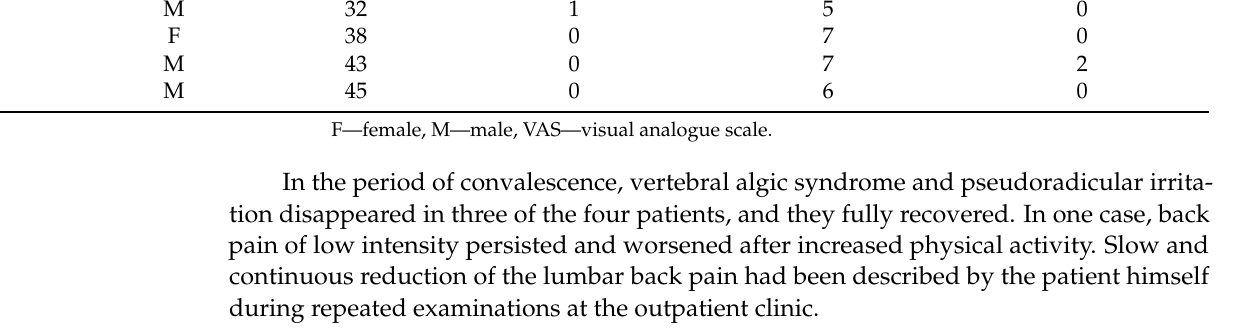
Table 1. VAS score in four patients prior to, during, and after COVID-19 infection. Patient